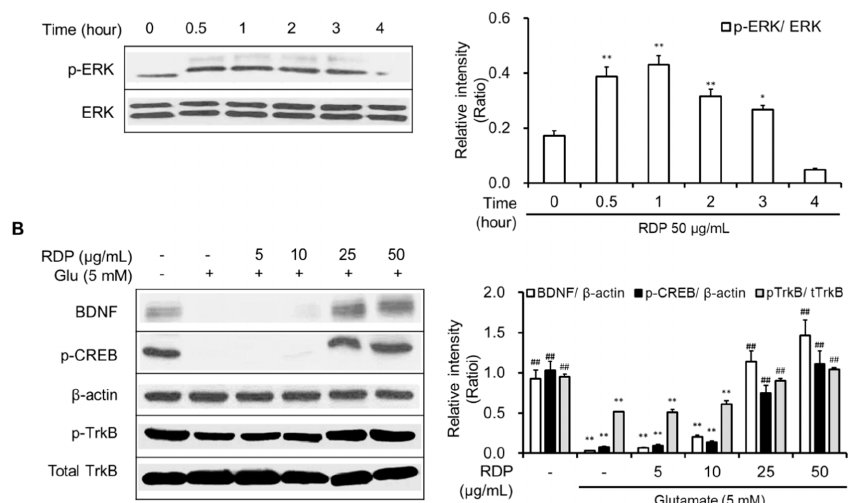
Figure 7. Activation of the ERK/BDNF/TrkB pathway in HT-22 cells by ethyl acetate extract of Ribes diacanthum Pall (RDP). The experiments were performed as elaborated in the Materials and Methods. The data were obtained from three independent experiments. ( A ) p-ERK, and ( B ) BDNF, p-CREB, β -actin, p-TrkB, and total TrkB. * p < 0.05, and ** p < 0.01 versus vehicle control group. ## p < 0.01 versus glutamate-treated group–indicates absence, + indicates presence.